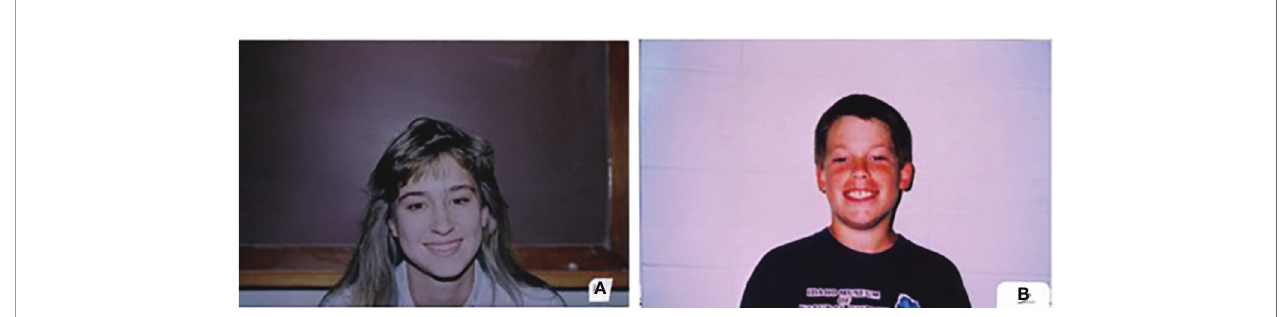
FIGURE 1 | Example images from the Diagnostic Analysis of Nonverbal Accuracy-2 depicting happy expressions from the (A) adult face subtest and (B) child